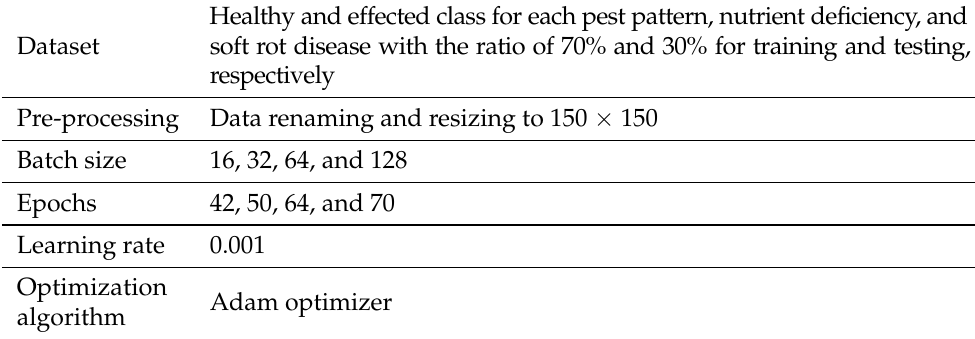
Table 1. Training hyper parameters for CNN, MobileNetV2 and